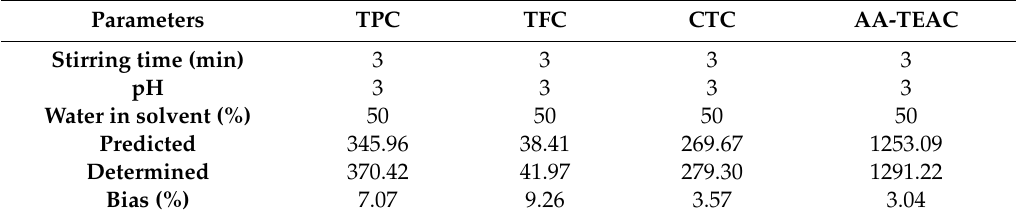
Figure 2. Response surface for predicting the recovery yield for total phenolic content ( TPC ), total flavonoid content ( TFC ), condensed tannin content ( CTC ,) and antioxidant activity ( AA ) by TEAC assay for hazelnut involucre extracts with regard to: X 1 , stirring time (min); X 3 , water in solvent (% v/v ); X 2 , pH = 5. The regions in red represent the domains of working conditions assuring the maximum extraction yield for the evaluated bioactive compounds. Table 6. Optimum experimental conditions for improved recovery of TPC, TFC, CTC, AA-TEAC from hazelnut involucre extracts.